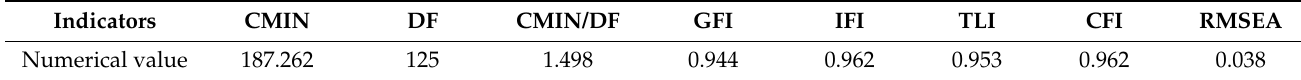
Table 6. Indicators of SRC incentive type model